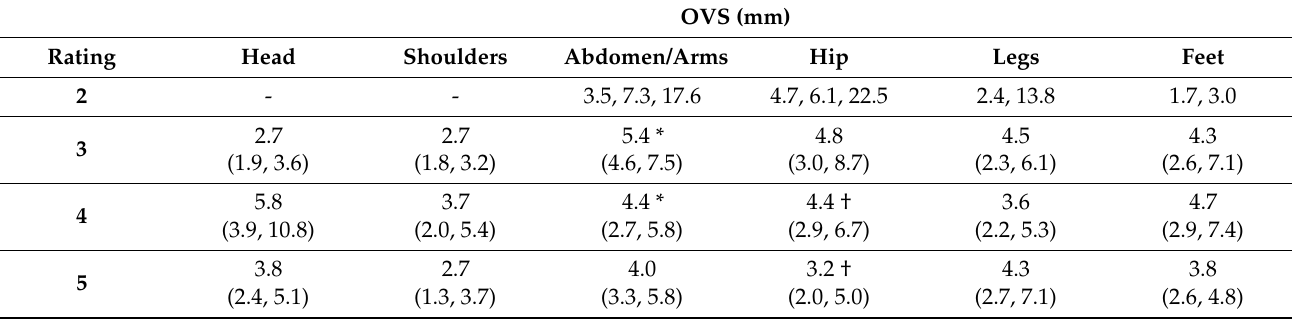
Table 2. Median values of the OVS between CBCT-CT grouped by qualitative rating. IQR values are reported in parentheses. Values for “rating 2” are reported explicitly due to the small sample size. No cases of “rating 1” were found.